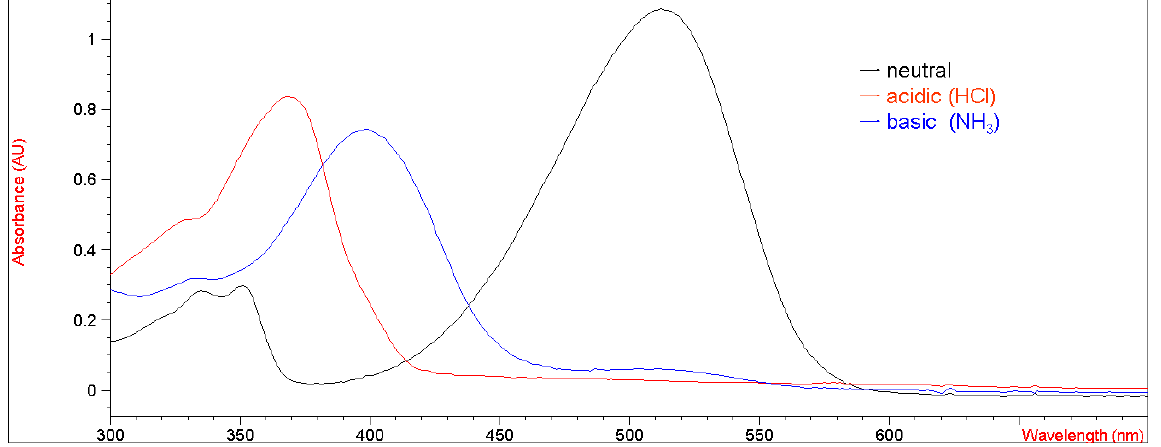
Figure 2. UV-vis spectra of 5b (2.14 x 10 -5 M in CH